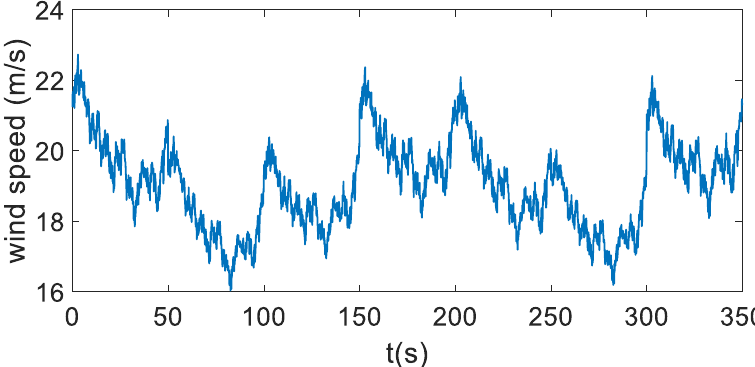
Figure 11. The wind speed in high wind speed region with severe turbulence.